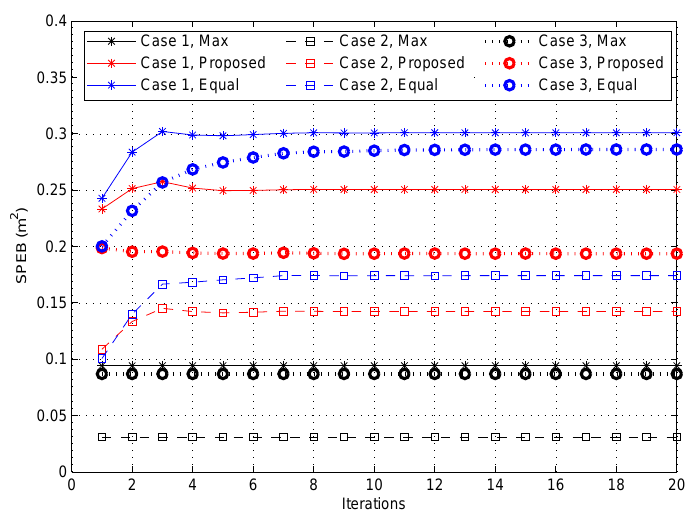
Figure 4. The square position error bound (SPEB) for different strategies in three cases.